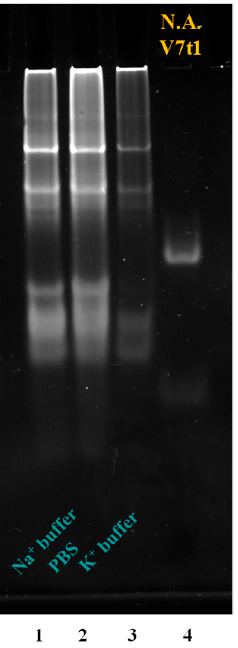
Figure 1. Representative 10% polyacrylamide gel electrophoresis under native conditions of MS3, at 3 µ M concentration in the indicated buffer solutions, run at constant 80 V at r.t. for 75 min in TBE 1 × buffer. The not-annealed (N.A.) V7t1 aptamer dissolved in HEPES/Na + buffer (25 mM HEPES, 150 mM NaCl, pH = 7.4) at 4 µ M concentration was used as reference oligonucleotide. Lane 1: